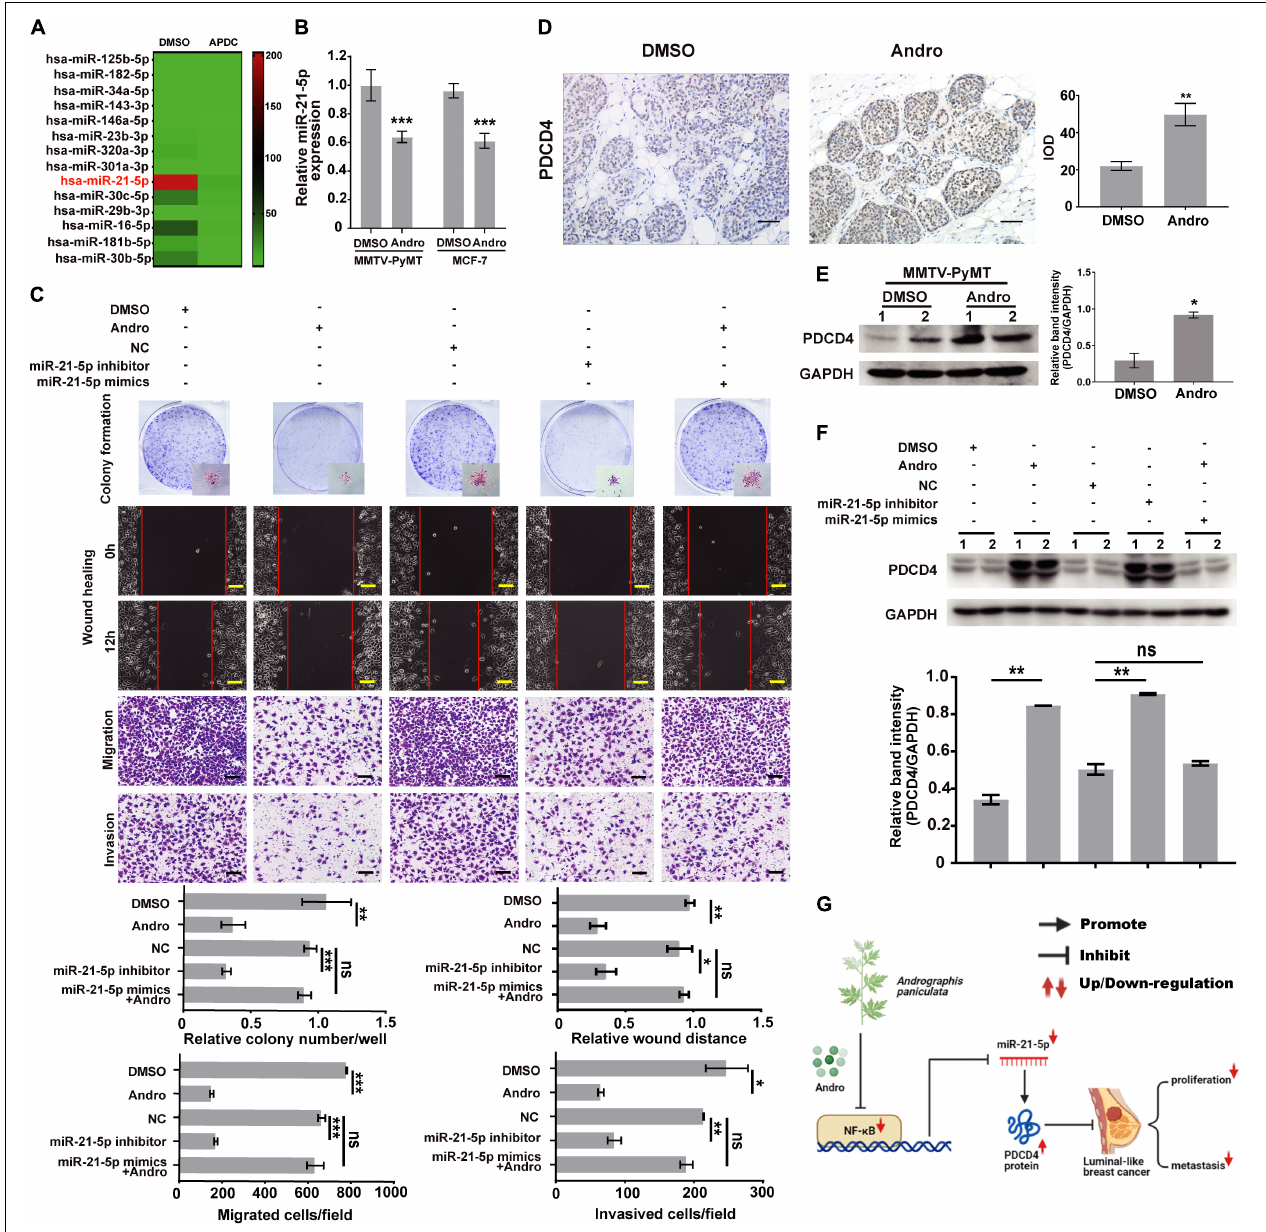
FIGURE 6 | Andrographolide (Andro) inhibits breast cancer cell proliferation, migration, and invasion via NF- κ B/miR-21-5p/PDCD4 signaling. (A) Heat map of the qRT-PCR data of miRNA expression in MCF-7 cells with or without NF- κ B inhibition. APDC: NF- κ B inhibitor. (B) miR-21-5p expression in breast cancer tissue and MCF cells was also detected using qRT-PCR. miR-21-5p was markedly suppressed by Andro in MCF-7 cells and MMTV-PyMT mice. (C) Colony formation, wound healing, Transwell migration, and Matrigel invasion assay. Immunohistochemistry (D) and Immunoblotting assay (E) for PDCD4 expression in DMSO- and Andro-treated MMTV-PyMT mice. (F) Immunoblotting analysis for PDCD4 expression in MCF-7 cells. (G) Schematic of the mechanisms of Andro-mediated effect on luminal-like breast cancer growth and metastasis. Quantitative data are expressed as the mean ± SD, n = 3. Significant effect: * P < 0.05, ** P < 0.01, *** P < 0.005. ns , no significant effect. Scale bar , 100 µ